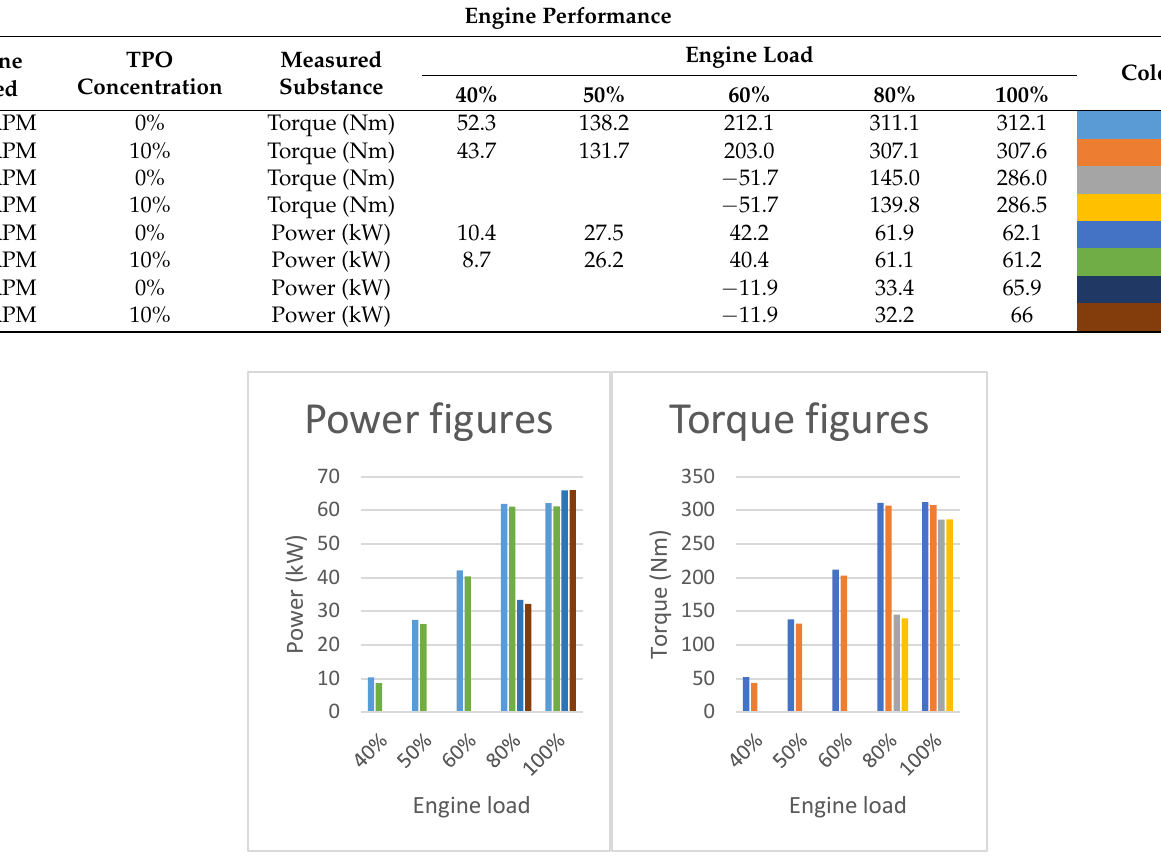
Figure 6. Torque and power curves of the engine. At 1900 RPM with lower loads, minimal power loss can be seen, but as the load increases, minimal power loss can be seen, but the difference decreases as the load increases. This is most likely caused by the higher heating value of TPO. At 2200 RPM at full load,